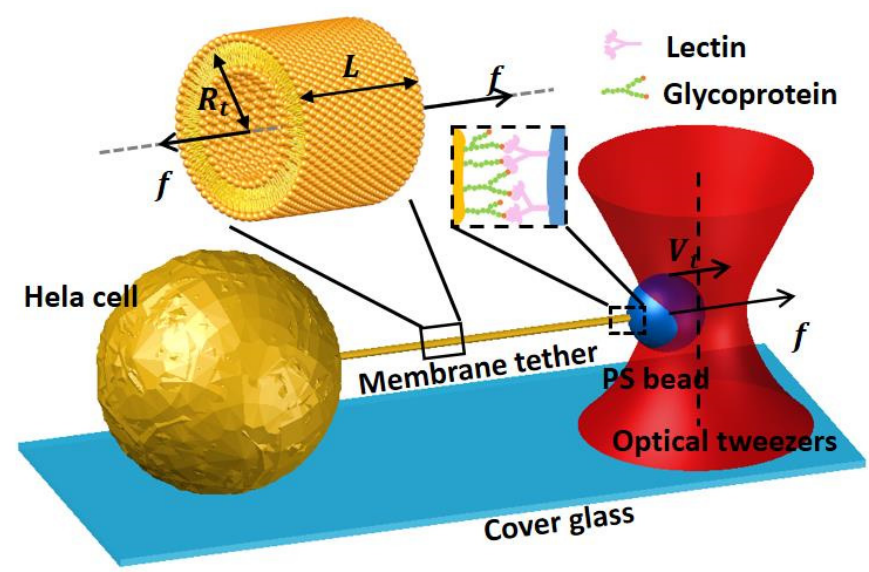
Figure 2. Optical tweezer pulling assay. A lectin-bound polystyrene bead is brought into proximity with a HeLa cell to form a tether to its glycoproteins. The optically trapped bead was manipulated away from the cell while the stretching force applied to the phospholipid bilayer was measured [21]. Reprinted with permission from Ref. [21]. Copyright © 2021 Oxford University